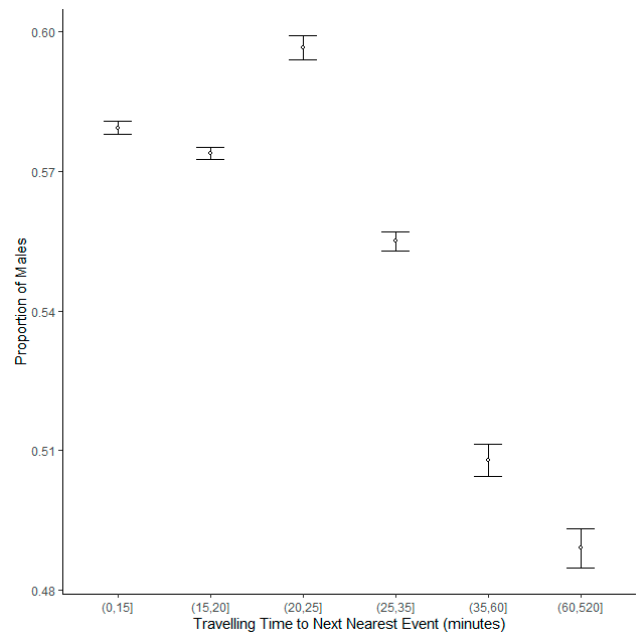
Figure 5. The proportion of male runners by travelling time in minutes to the next nearest parkrun event. Error bars represent 95% confidence intervals.